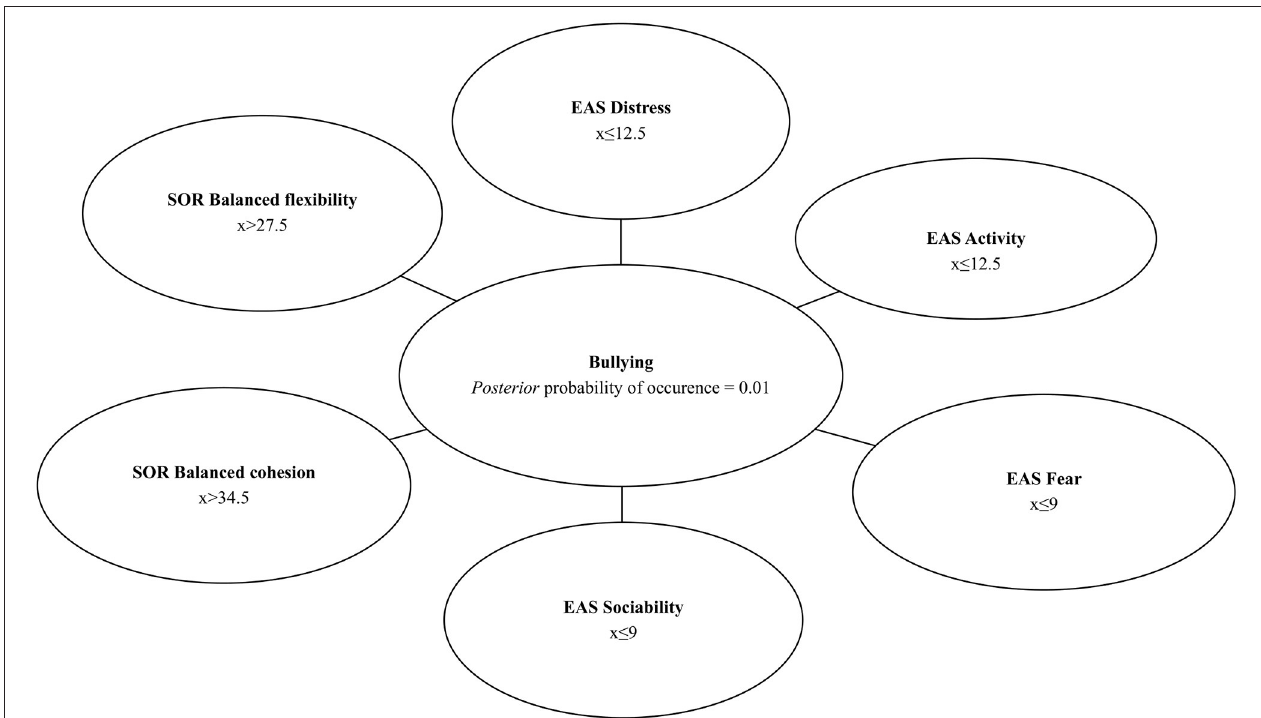
FIGURE 2 | Bayesian network–low posteriori conditional probability of bullying.